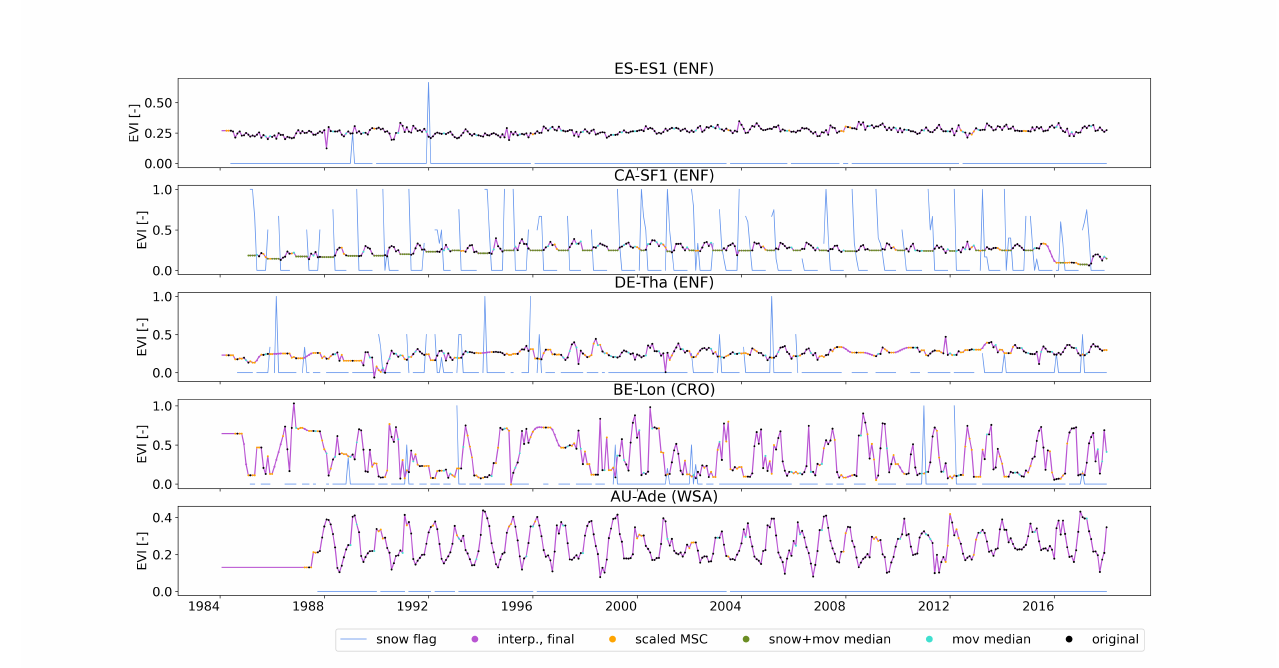
Figure 5. Illustration of gap-filling steps in the 30m pixel containing selected eddy-covariance sites for the Landsat